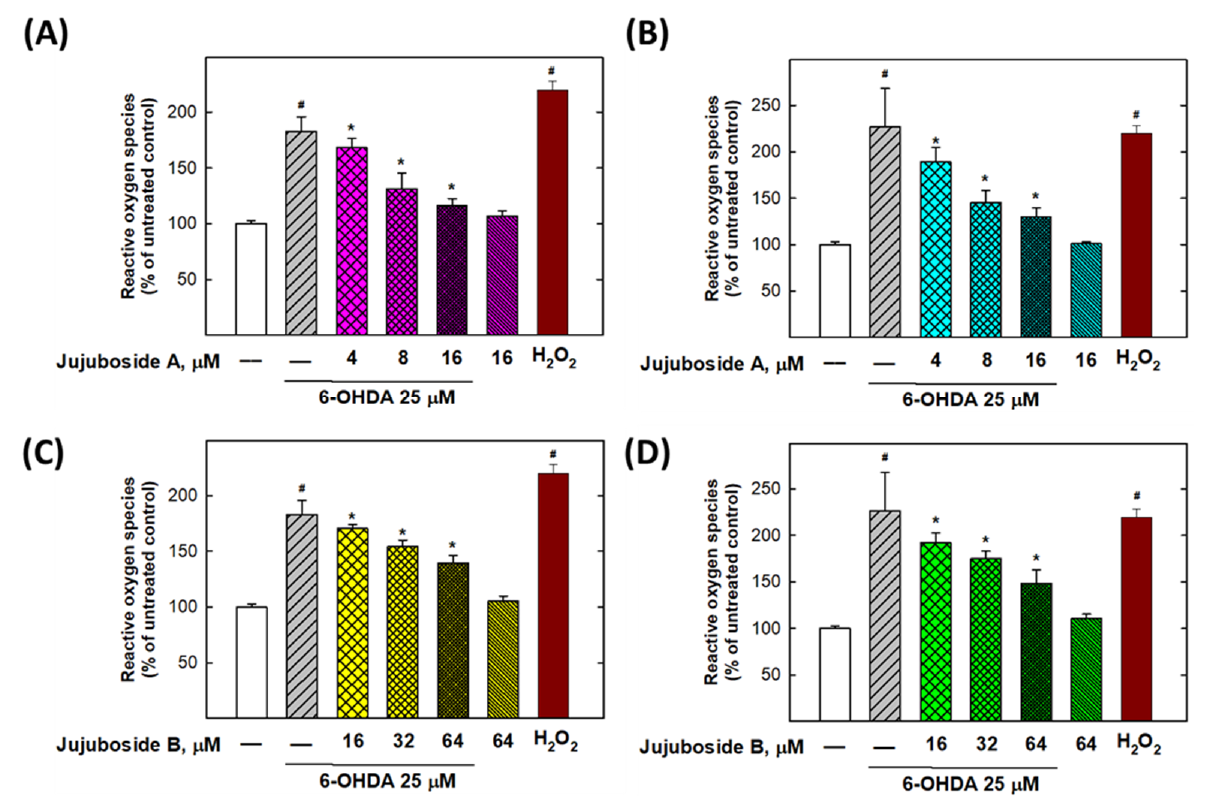
Figure 8. Jujuboside A and B reversed the 6-OHDA-induced reactive oxygen species (ROS) in SH- SY5Y and SK-N-SH cells. ( A , B ) Effects of jujuboside A on SH-SY5Y and SK-N-SH intracellular ROS, respectively. ( C , D ) Effects of jujuboside B on SH-SY5Y and SK-N-SH intracellular ROS, respectively. * Statistically significant from 6-OHDA 25 μM group. # Statistically significant from untreated group. Each experiment was repeated for at least 6 times.